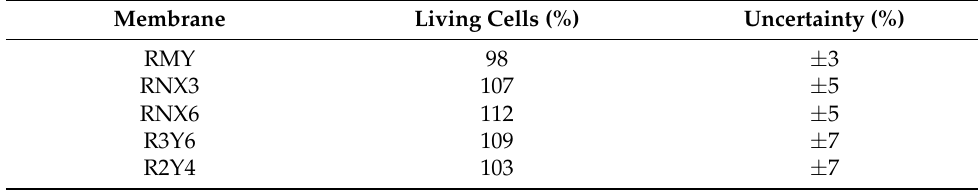
Table 3. Results from the cytotoxicity analysis.